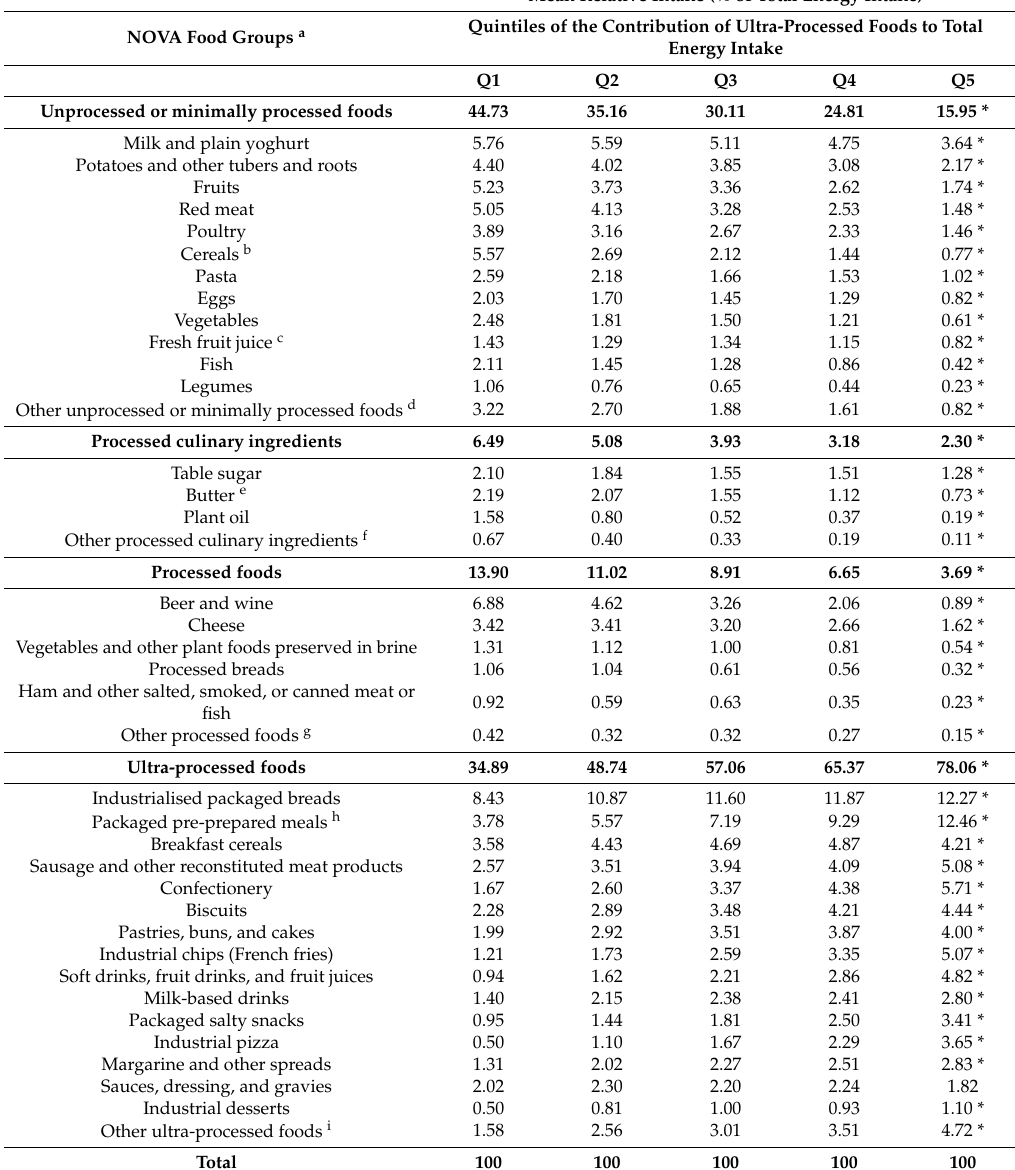
Table 2. Distribution (%) of total energy intake according to NOVA food groups across strata